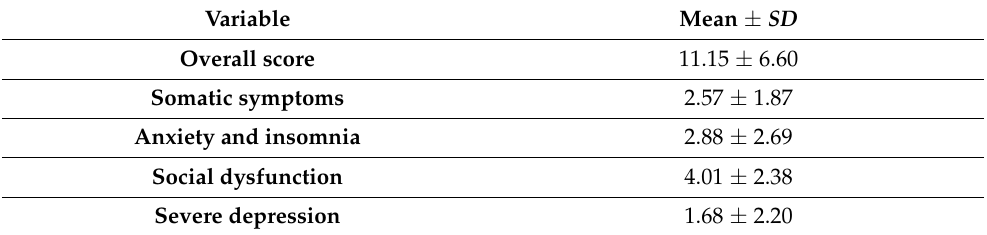
Table 3. General Health